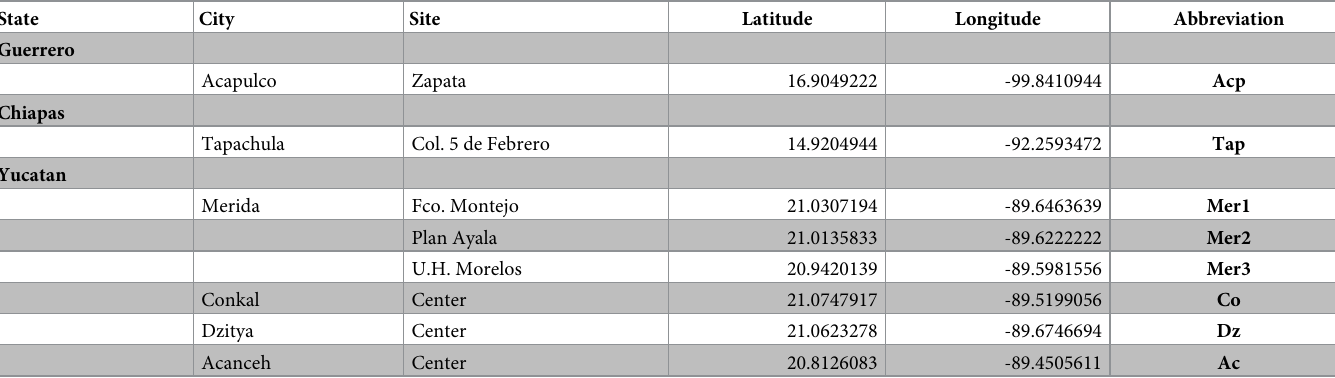
Table 1. Collection sites by state and city, geographical coordinates, and site